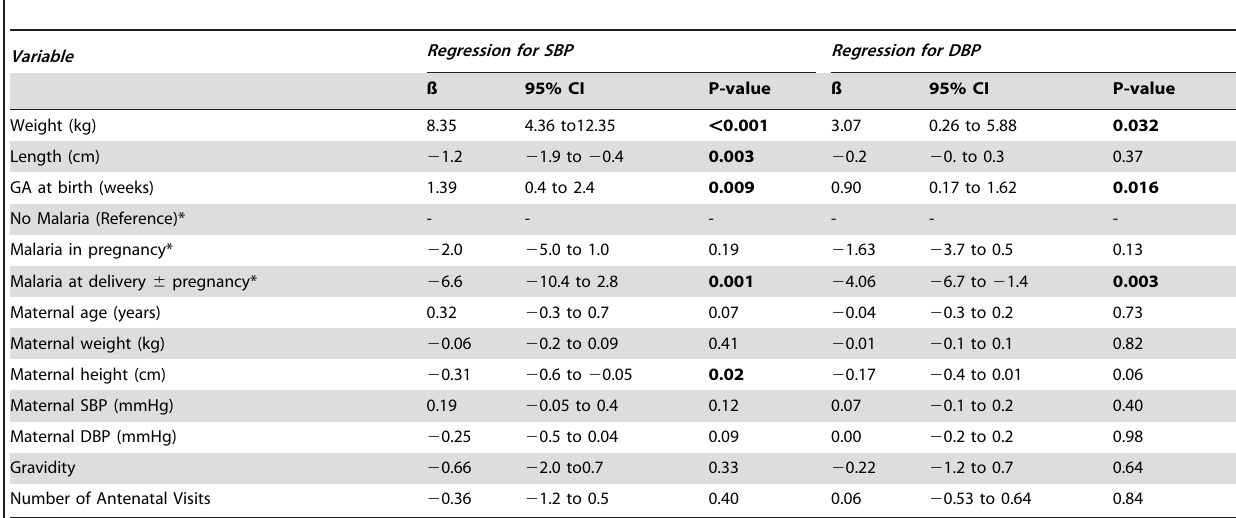
Table 7. Multiple regression analyses for determinants of newborn SBP and DBP at birth including maternal malaria timing.